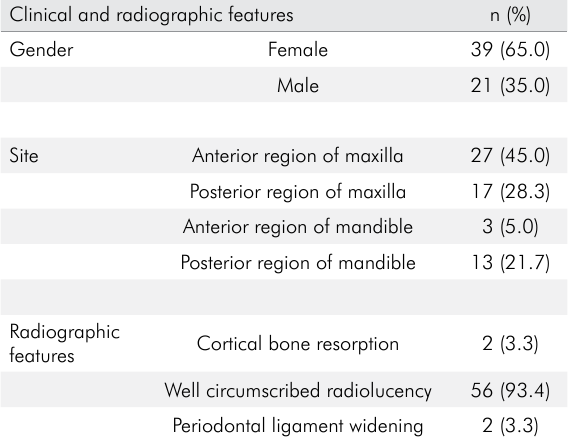
Table 2. Site and radiographic features of periapical